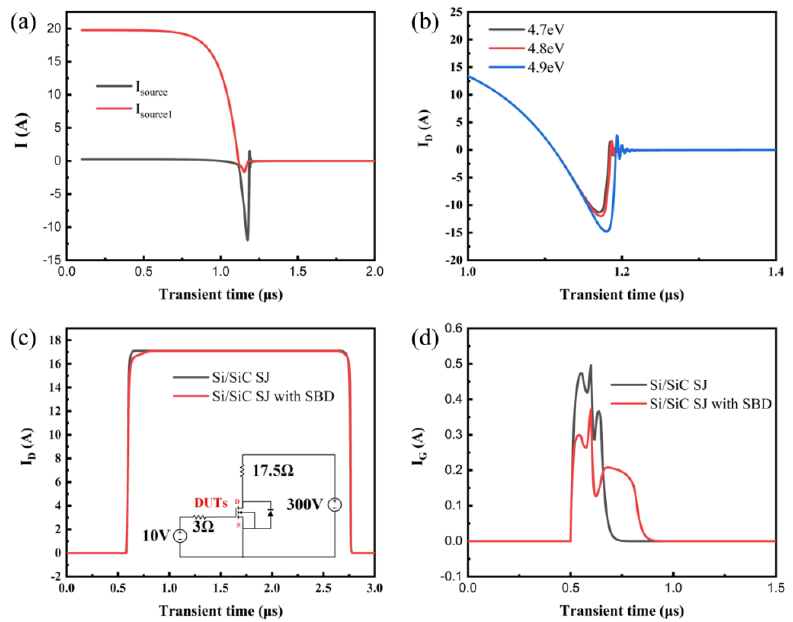
Figure 4. ( a ) Reverse recovery current of Si/SiC SJ with SBD, which the work function of source1 is 4.8 eV. ( b ) Reverse recovery current with different work functions. ( c ) Switch waveforms of body diodes of three SJ MOSFETs and the simulation circuit. ( d ) Gate current waveform of two SJ